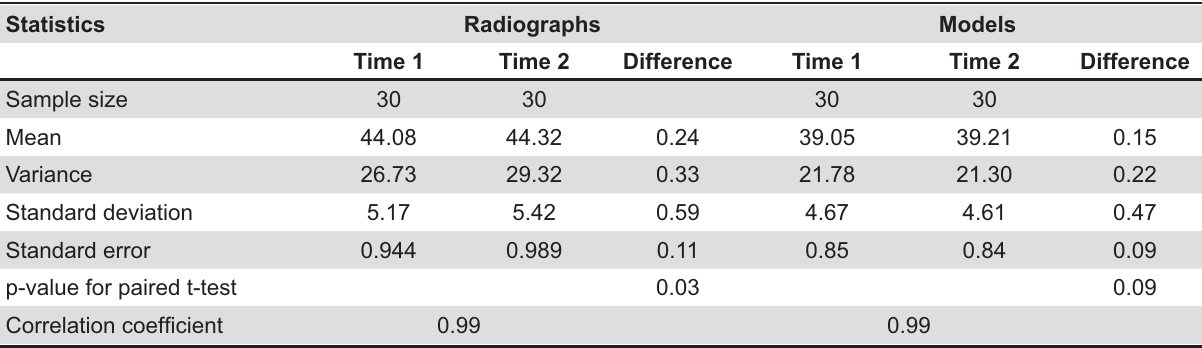
Table 1- Data analysis for upper-arch length projected onto the midsagittal plane in millimeters measured from models and cephalometric radiographs, each on two separate occasions (in mm)